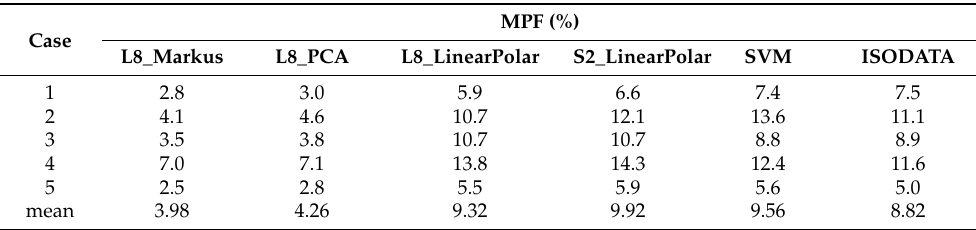
Table 5. The average MPF of the 5 cases using the three algorithms on L8 and one algorithm and two classification algorithms on